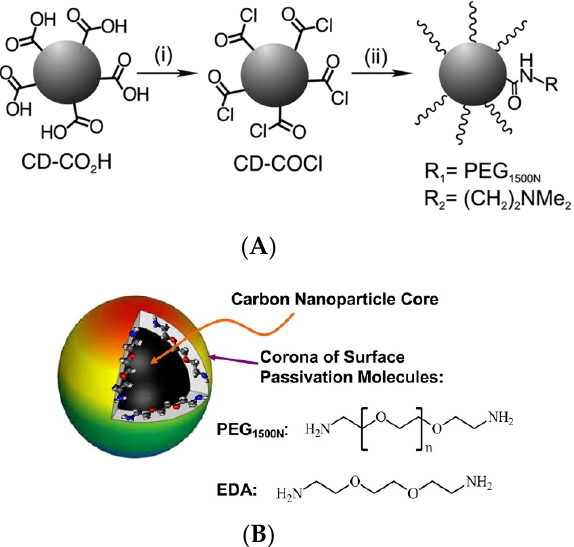
Figure 5. ( A ) Surface passivation of CD containing carboxyl groups (CD-COOH) to CD-COCl using an acyl chloride; (i) SOCl 2 , reflux; (ii) addition of alcohol or amine reagents, such as PEG 1500N or